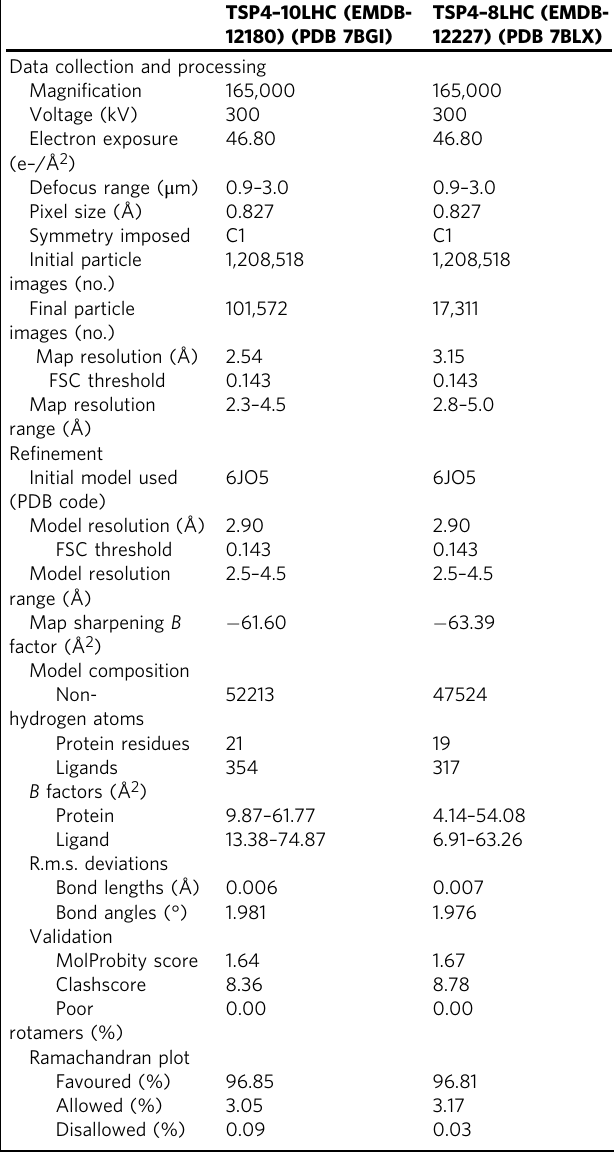
Table 1 Cryo-EM data collection, re fi nement and validation